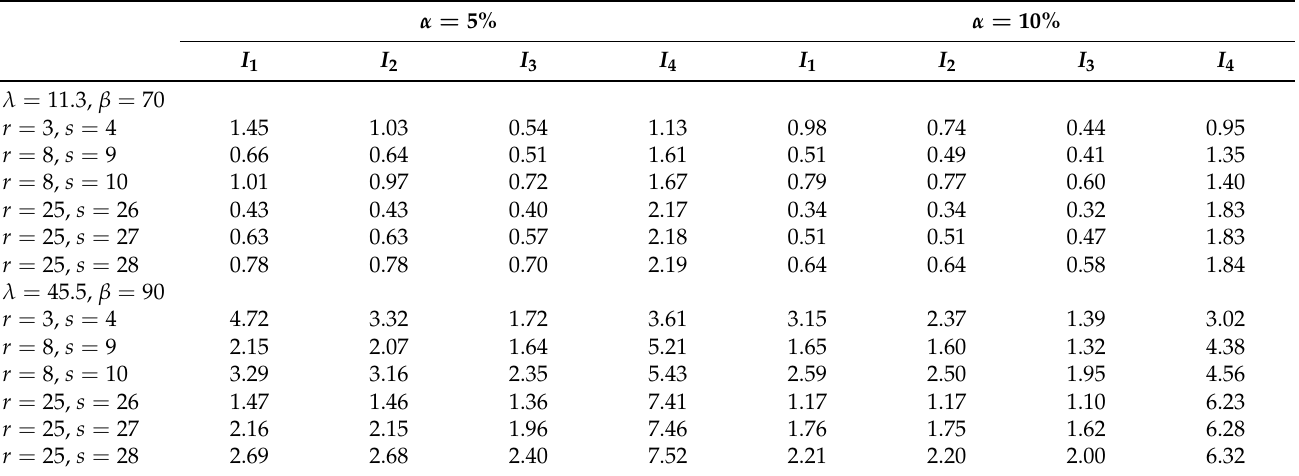
Table 1. Expected lengths of the 95% and 90% prediction intervals I 1 , . . . , I 4 for the s th lower record value based on the first r records from a Pow ( λ , β ) distribution.